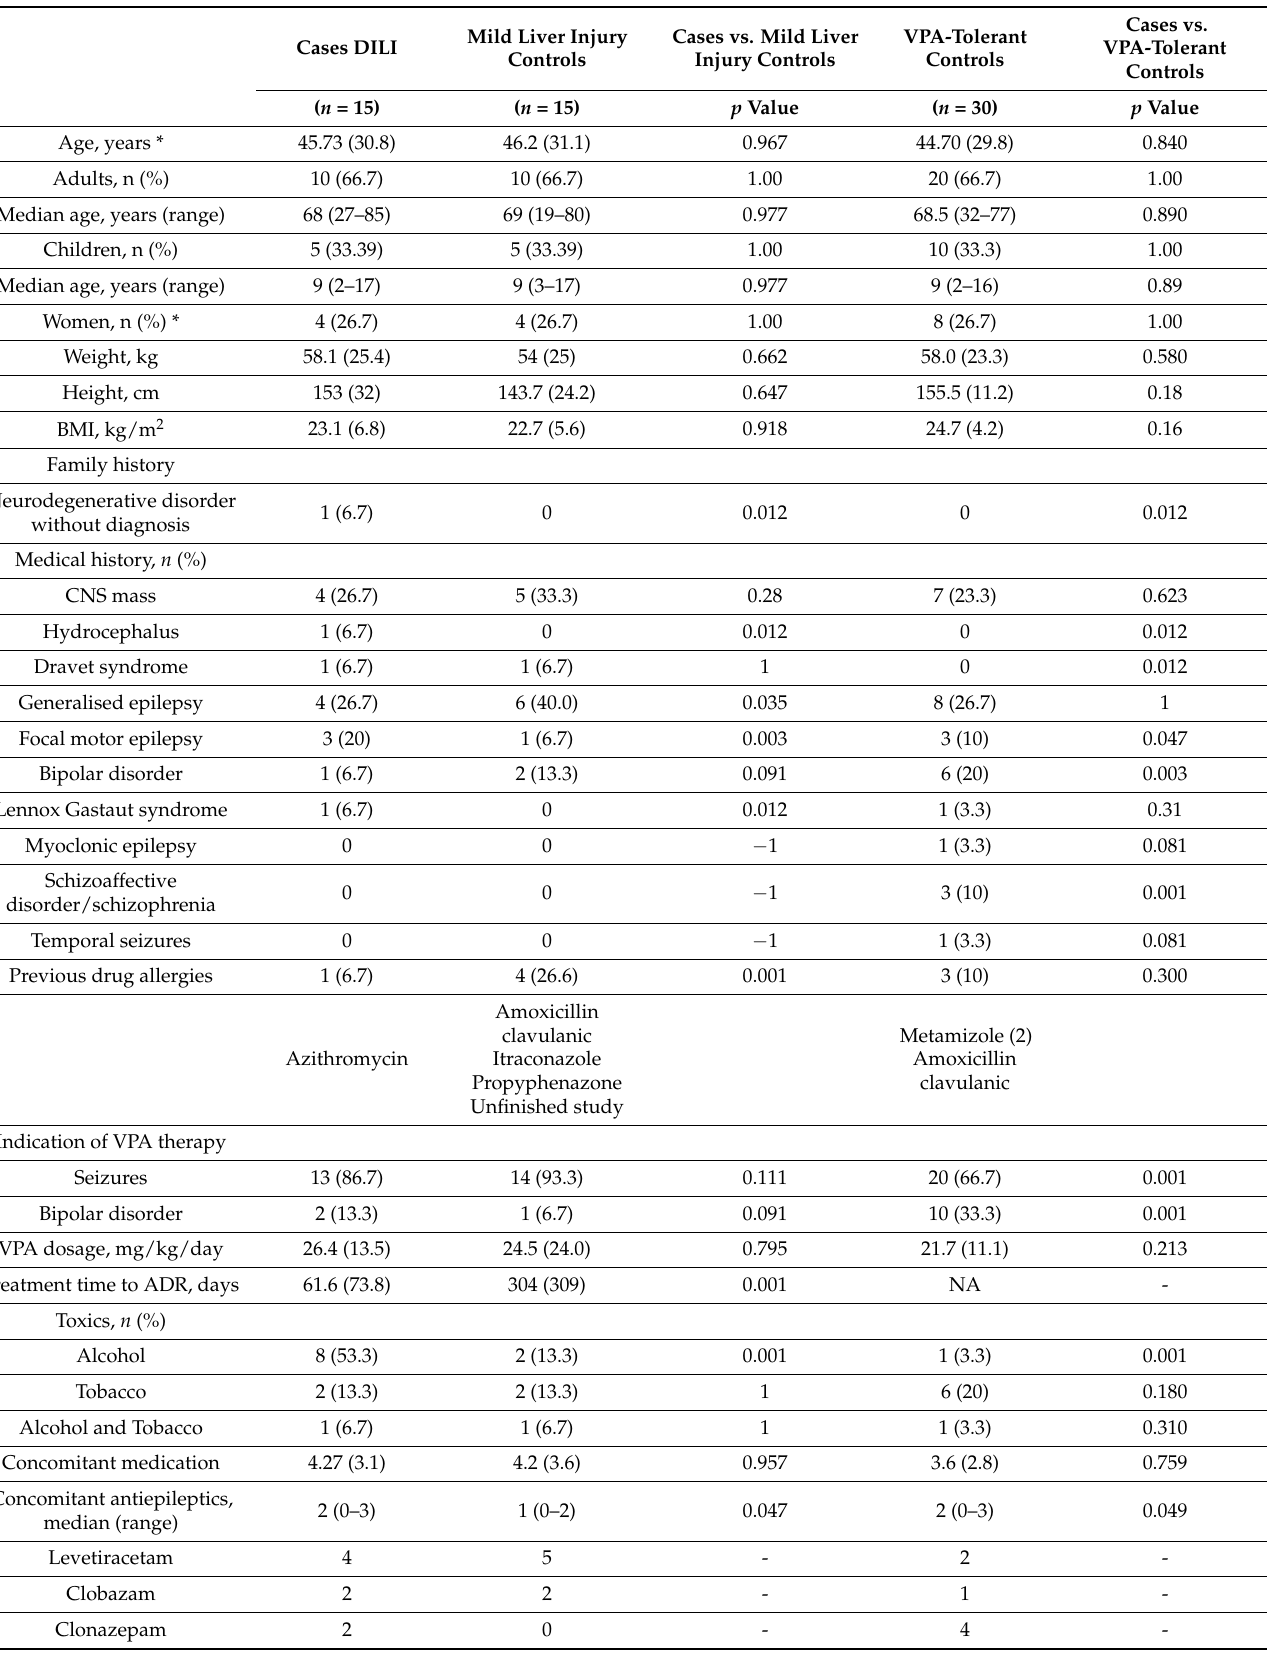
Table 1. Characteristics of cases Drug-induced liver injury (DILI) by valproic acid (VPA) compared with mild liver injury controls and with VPA-tolerant